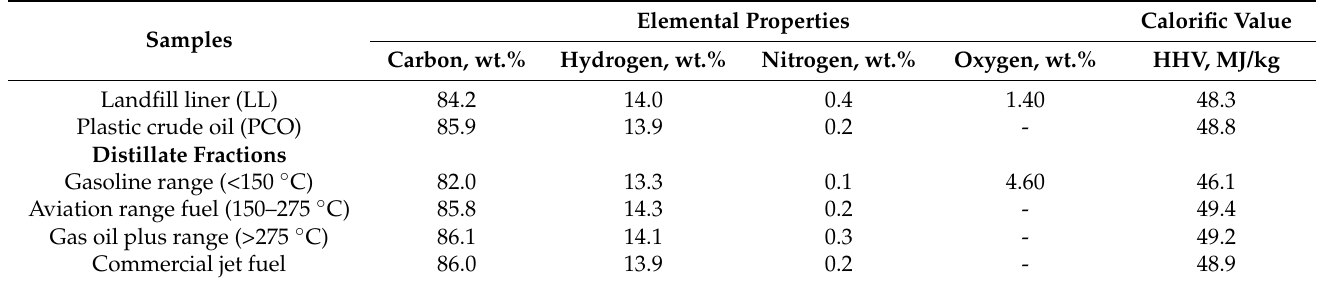
Table 7. Elemental properties of landfill liner plastic waste and its pyrolyzed